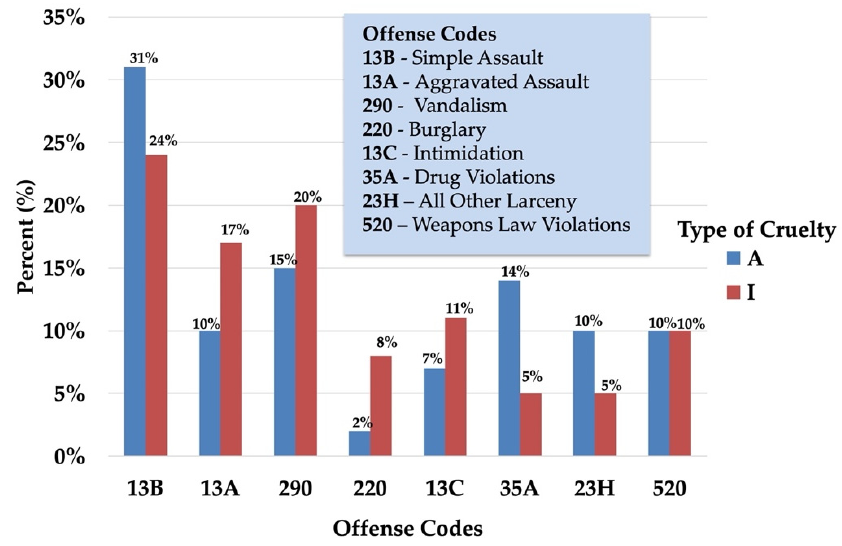
Figure 10. Co Occurring Offenses as a Function of Type of Animal Cruelty (A) and (I).